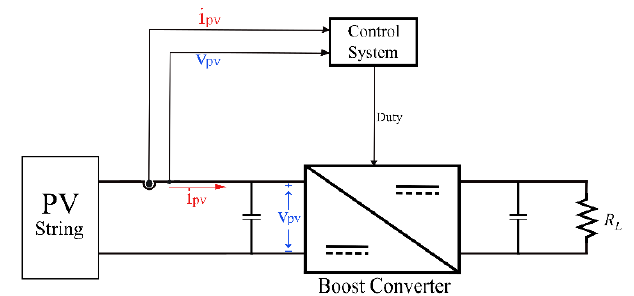
Figure 2. The block diagram of the PV system.